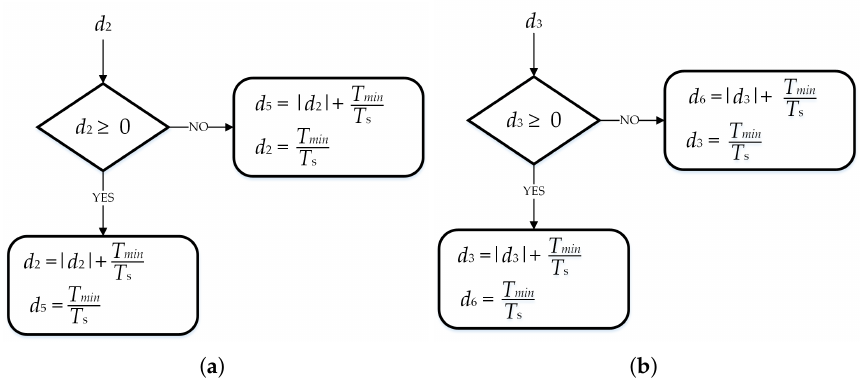
Figure 5. Reference and basic vectors’ components.